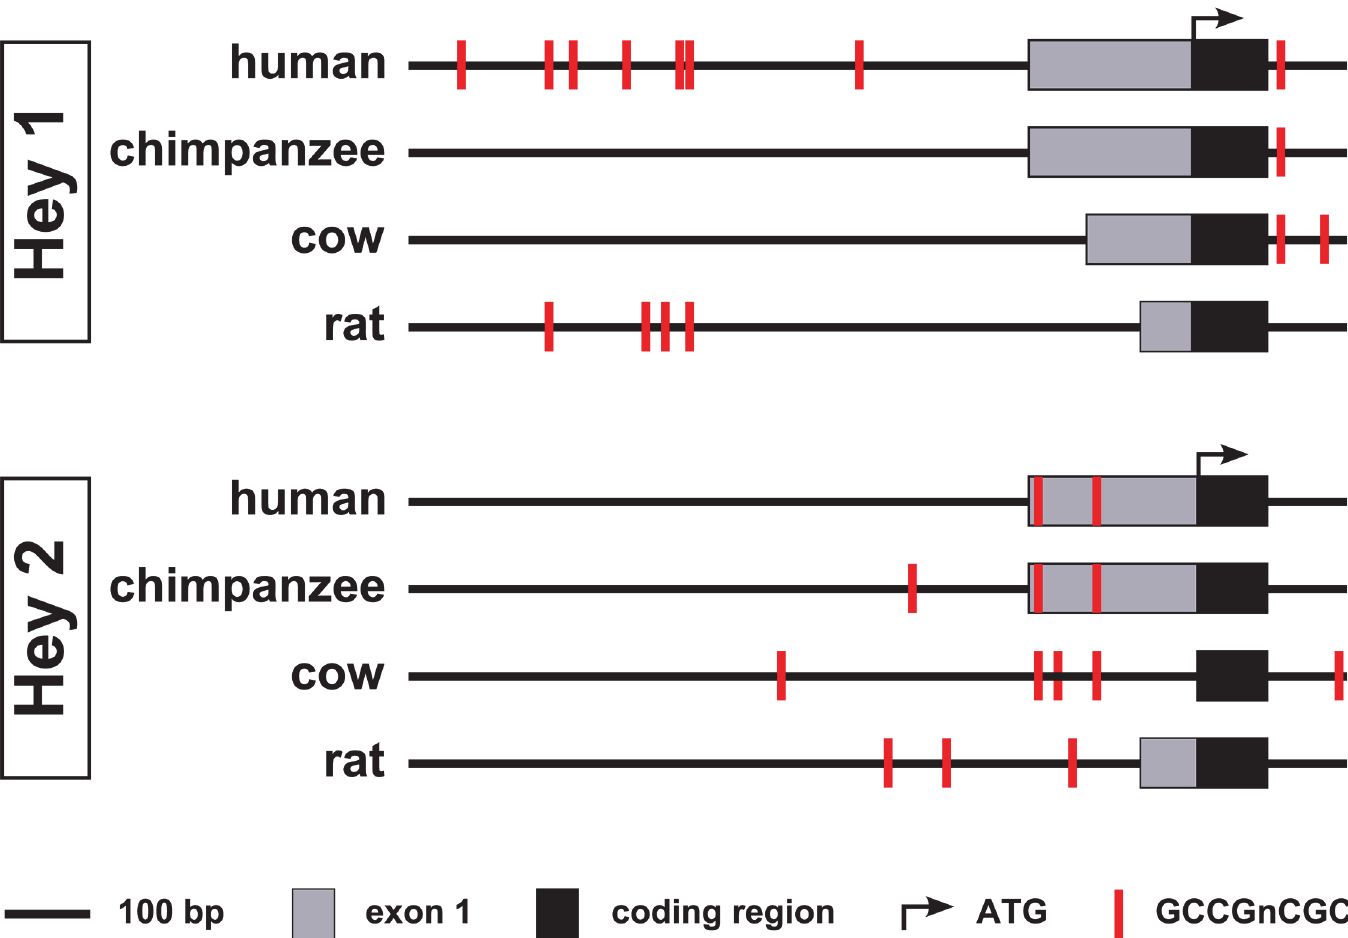
Fig 4. Smad1 binding sites in the promoter regions of Hey1 and Hey2 . Schematic alignment of the Hey1 and Hey2 promoters of Homo sapiens (human), Pan troglodytes (chimpanzee), Bos Taurus (cow) and Rattus norvegicus (rat). Potential Smad1 binding sites (GCCGnCGC) are depicted in red. For a clearer visualization, recognition sites, which are separated by less than 10 bp, are only depicted by one red